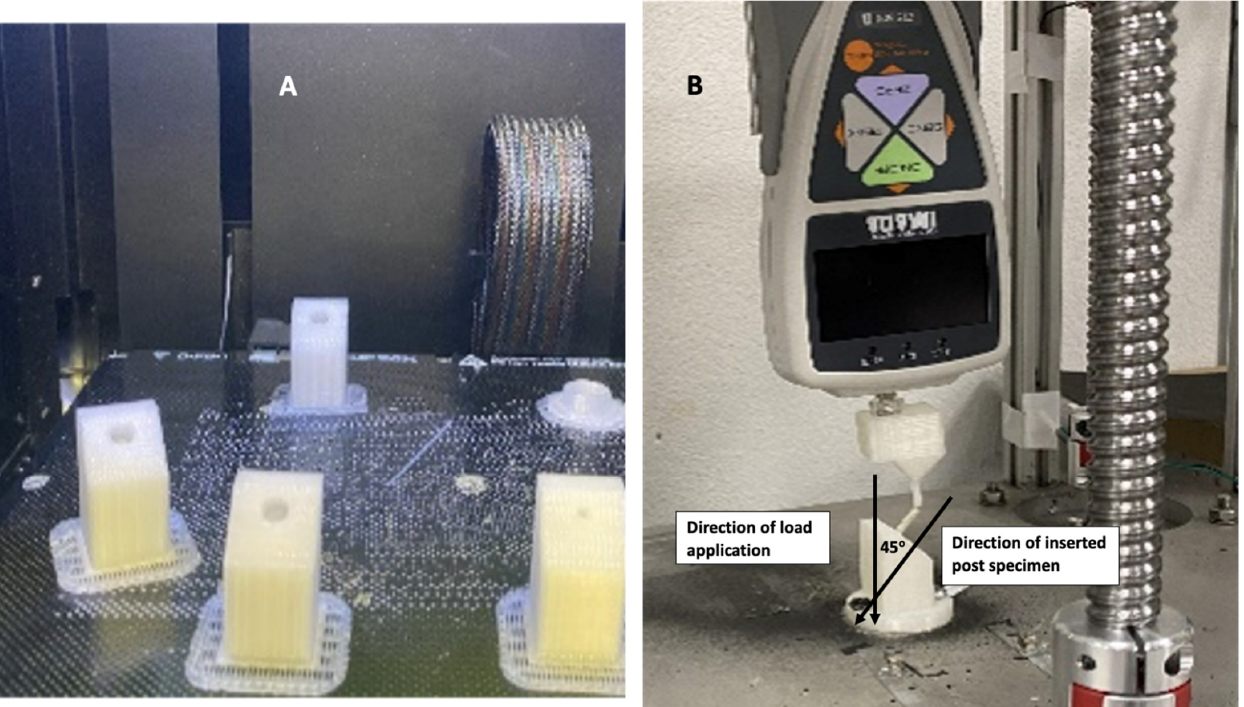
Figure 2. Two-point bending strength ( A ) 3D printed specimen holder, ( B ) The applied force on the fiber post in a way to form a vector force of 45° as two-point bending stress.